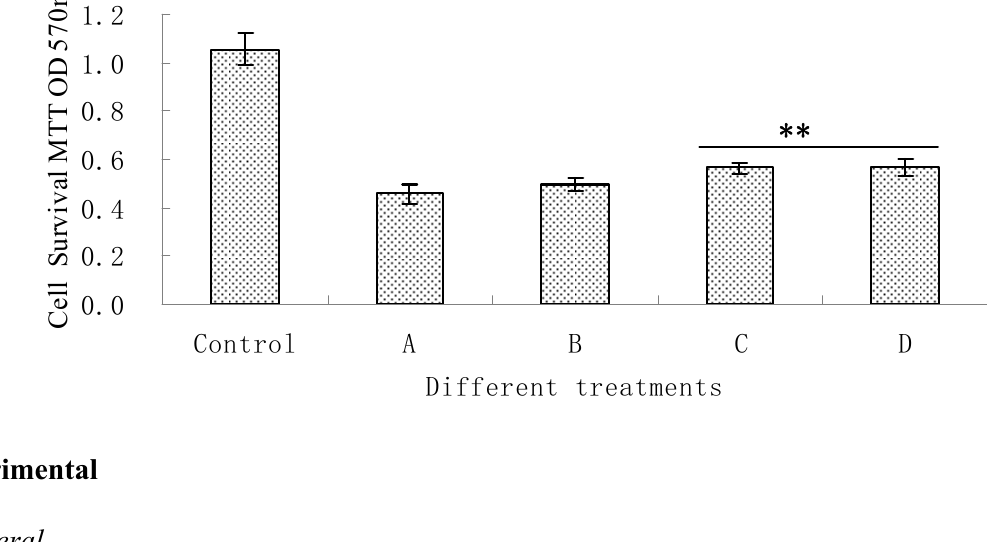
on H O -induced cytotoxicity in 1 2 2 O + 5 μ M oleiferasaponin A 2 2